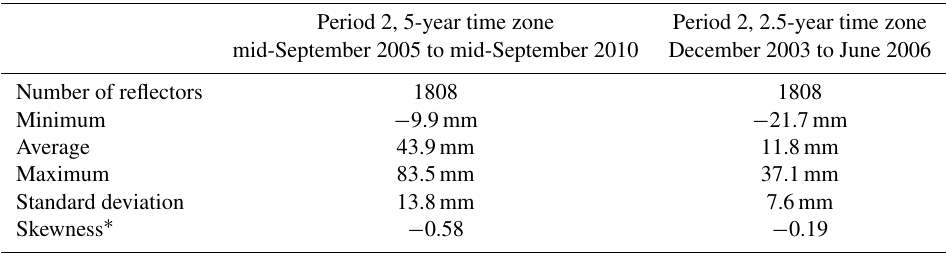
Table 2. Information on total surface movement during the two times zones of 5 and 2.5 years considered in the second observation period for the total area studied.